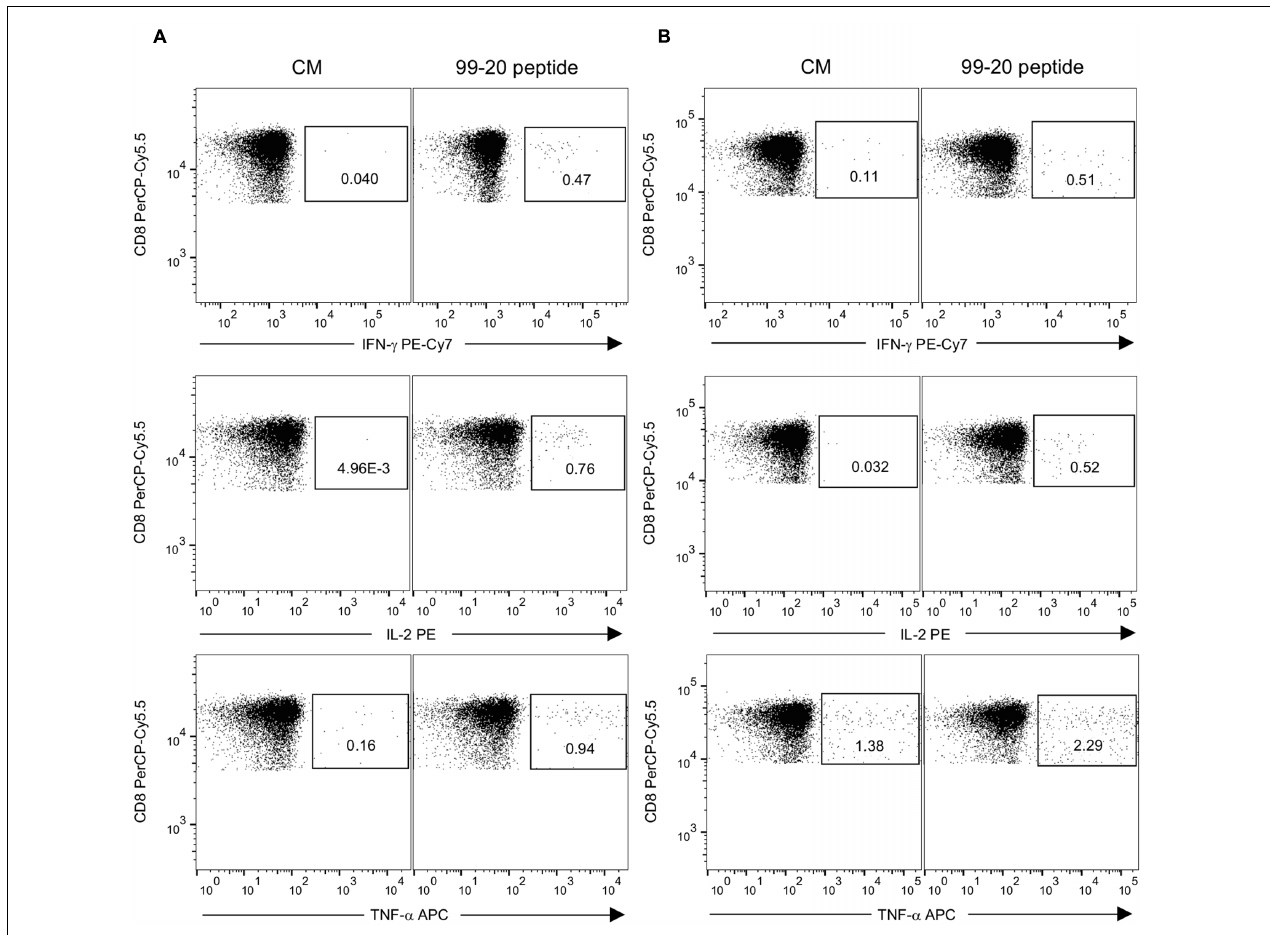
FIGURE 7 | Expression of IFN- γ , IL-2, and TNF- α by intracellular staining after stimulation with NoV GII.4-1999 peptide epitope 99-20. Peripheral blood mononuclear cells (PBMCs) of donors #2 having A ∗ 01:01/ ∗ 02:01; B ∗ 08:01/ ∗ 56:01; C ∗ 01:02/ ∗ 07:01 HLA class I phenotype alleles (A) and #4 having A ∗ 02:01/ ∗ 32:01; B ∗ 35:01/ ∗ 40:02; C ∗ 03:04/ ∗ 04:01 HLA class I phenotype alleles (B) were stimulated with 2 µ g/ml of 99-20 single peptide for 16 h and the cytokine response was measured by flow cytometry. PBMCs in culture media only (CM) (left panel) and peptide-stimulated PBMCs (right panel) were gated to CD3 + CD8 + T cells and the percentages of IFN- γ , IL-2, or TNF- α cytokine-expressing cells are